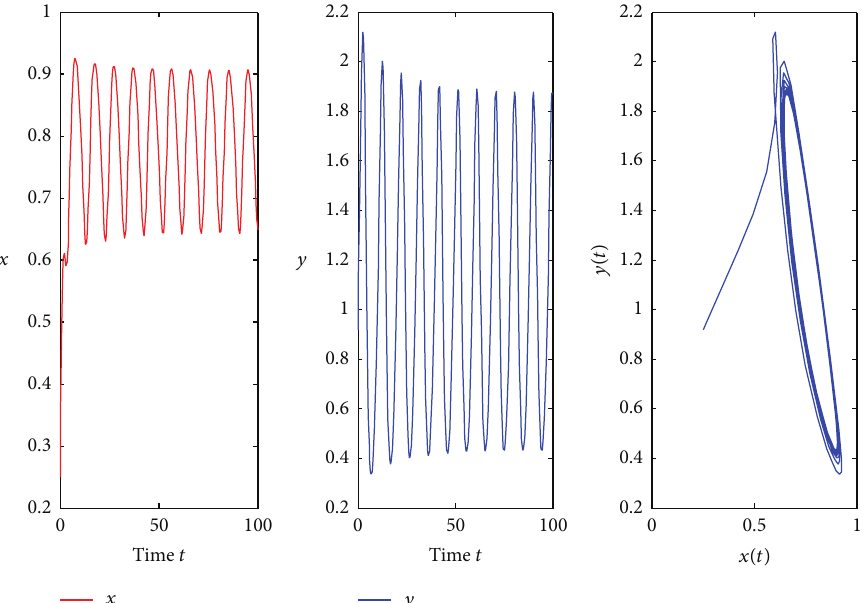
Figure 4: 𝐸 ∗ is unstable for 𝜏 2 = 2.05 > 𝜏 20 = 1.8631 with initial values